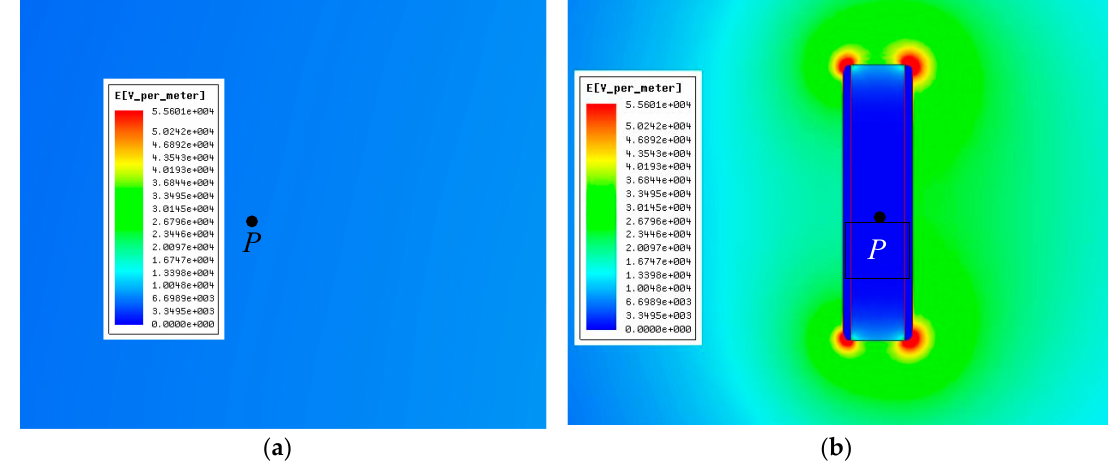
Figure 5. Electric field spatial distribution surrounding observation point P (no influence of a human body). ( a ) Before placing the sensor; ( b ) after placing the sensor.